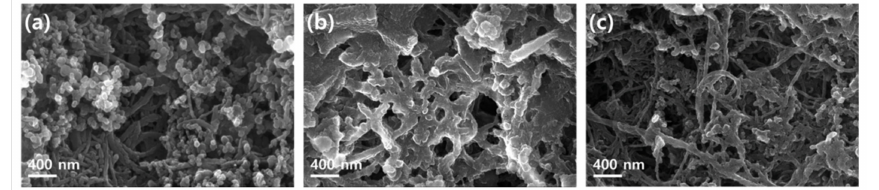
Figure 4. FE-SEM images of the samples: ( a ) before cell test, ( b ) after 5 cycle charging the Only PH sample, ( c ) after 5 cycle charging the PH-Iodine RPC sample.